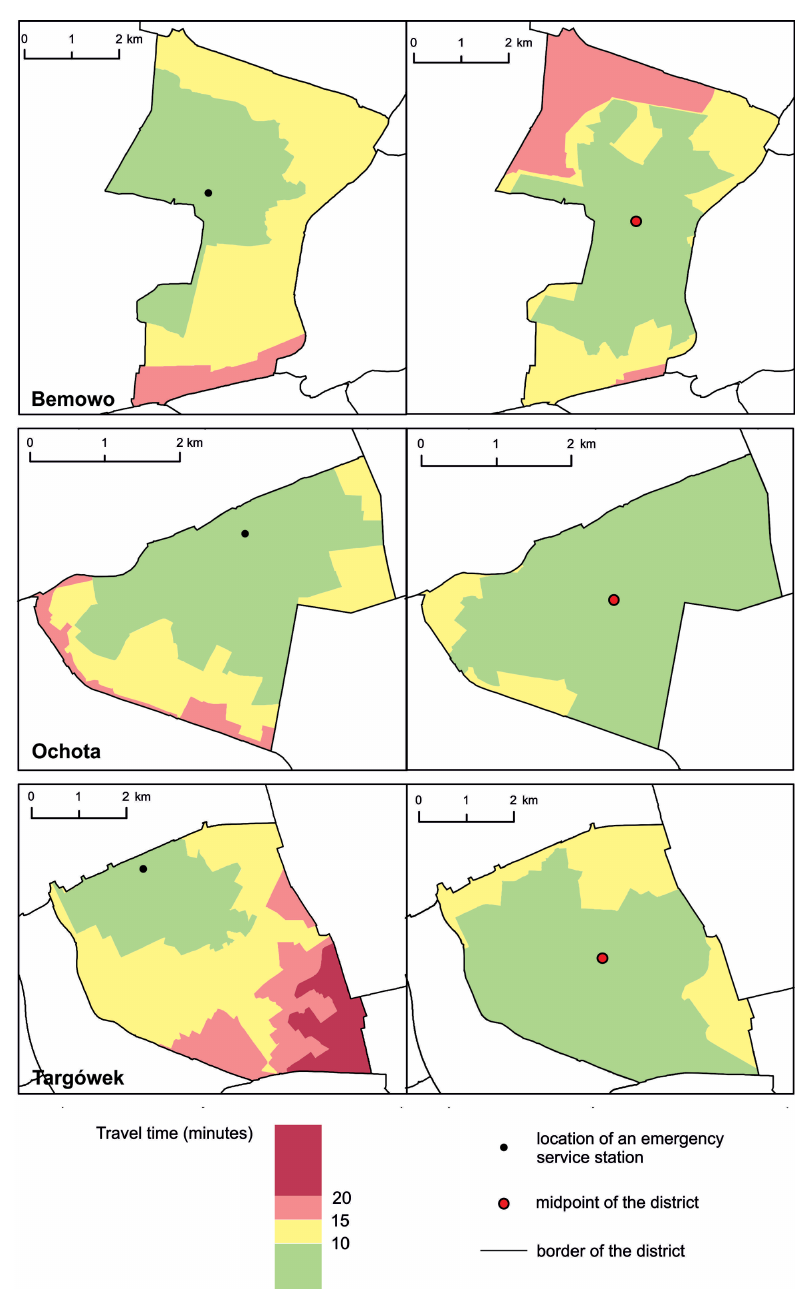
Fig. 6. Time availability in the Bemowo, Ochota and Targówek districts − before and after changing the location of the emergency service station (own